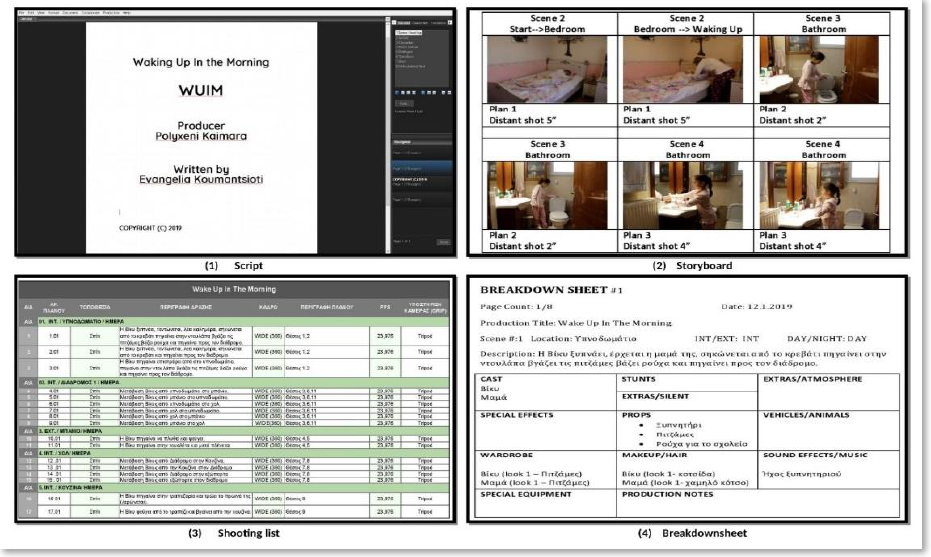
Figure 15. Pre-production phase: script, storyboard, shooting list and breakdown sheets. For the storyboard, we chose to proceed with photo shooting so that along with the technical information needed for the video recordings, such as objects (props), lighting, costumes, characters, sounds, the actors rehearsed their “ role ” , etc. Consequently, we proceeded with the shotlist and the breakdown sheets. Shots were taken during the production phase with a 360° camera (Figures 16 and 17).